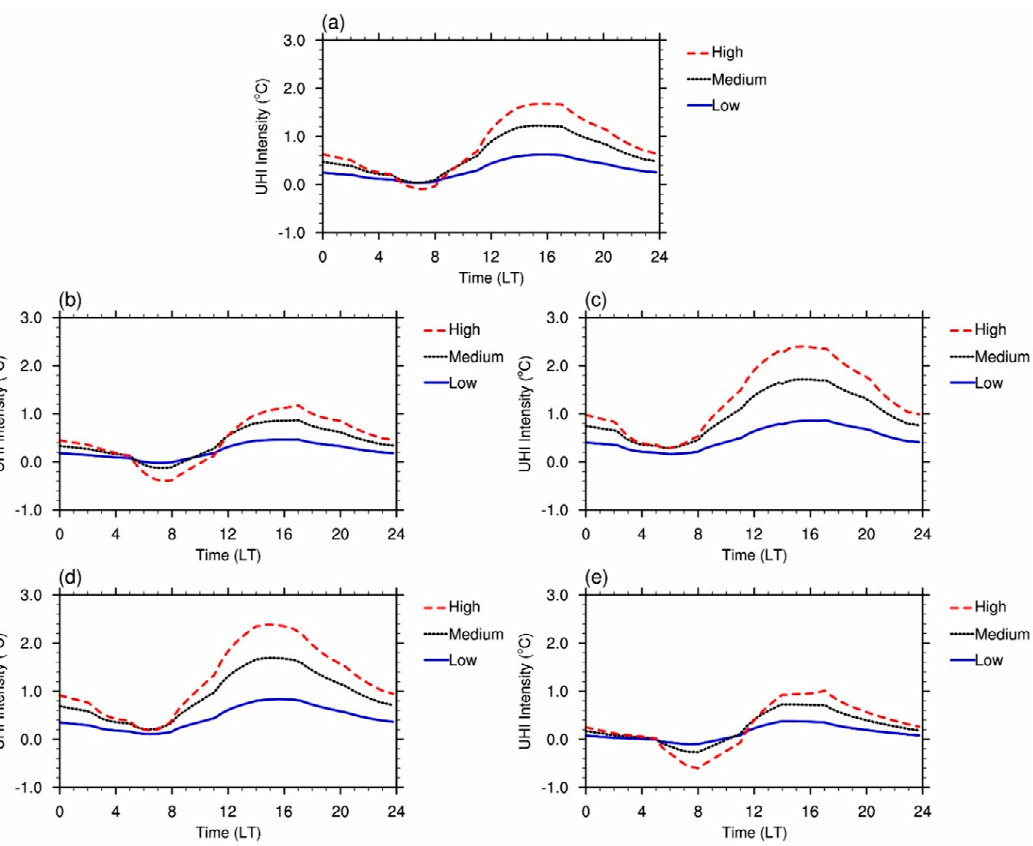
Figure 8. Diurnal variations of urban heat island (UHI) intensities over different urban type areas: ( a ) annual average; ( b ) spring average; ( c ) summer average; ( d ) autumn average; and ( e ) winter average.